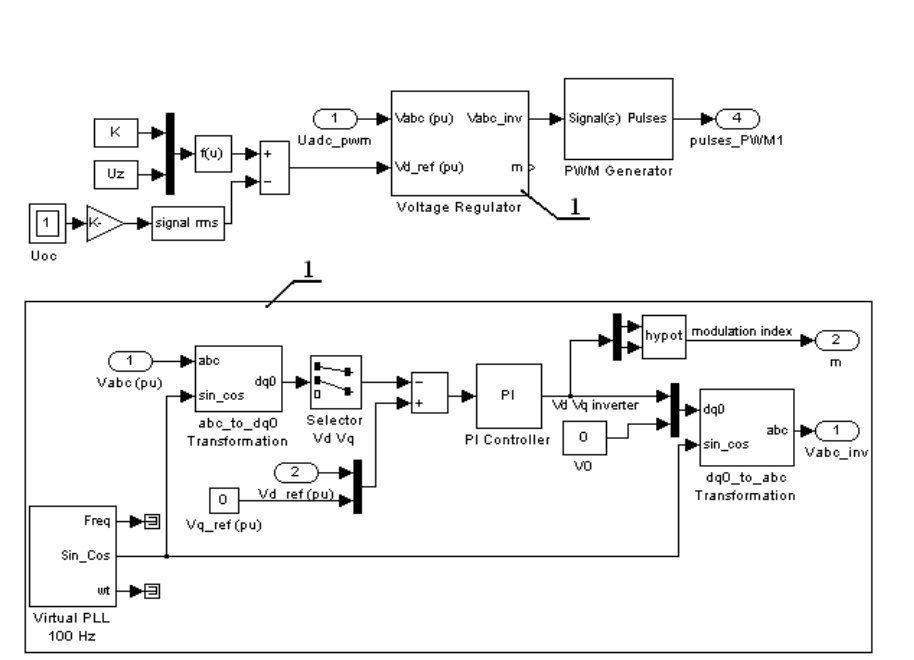
Figure 7. Simulation model of control system of autonomous inverter AVI